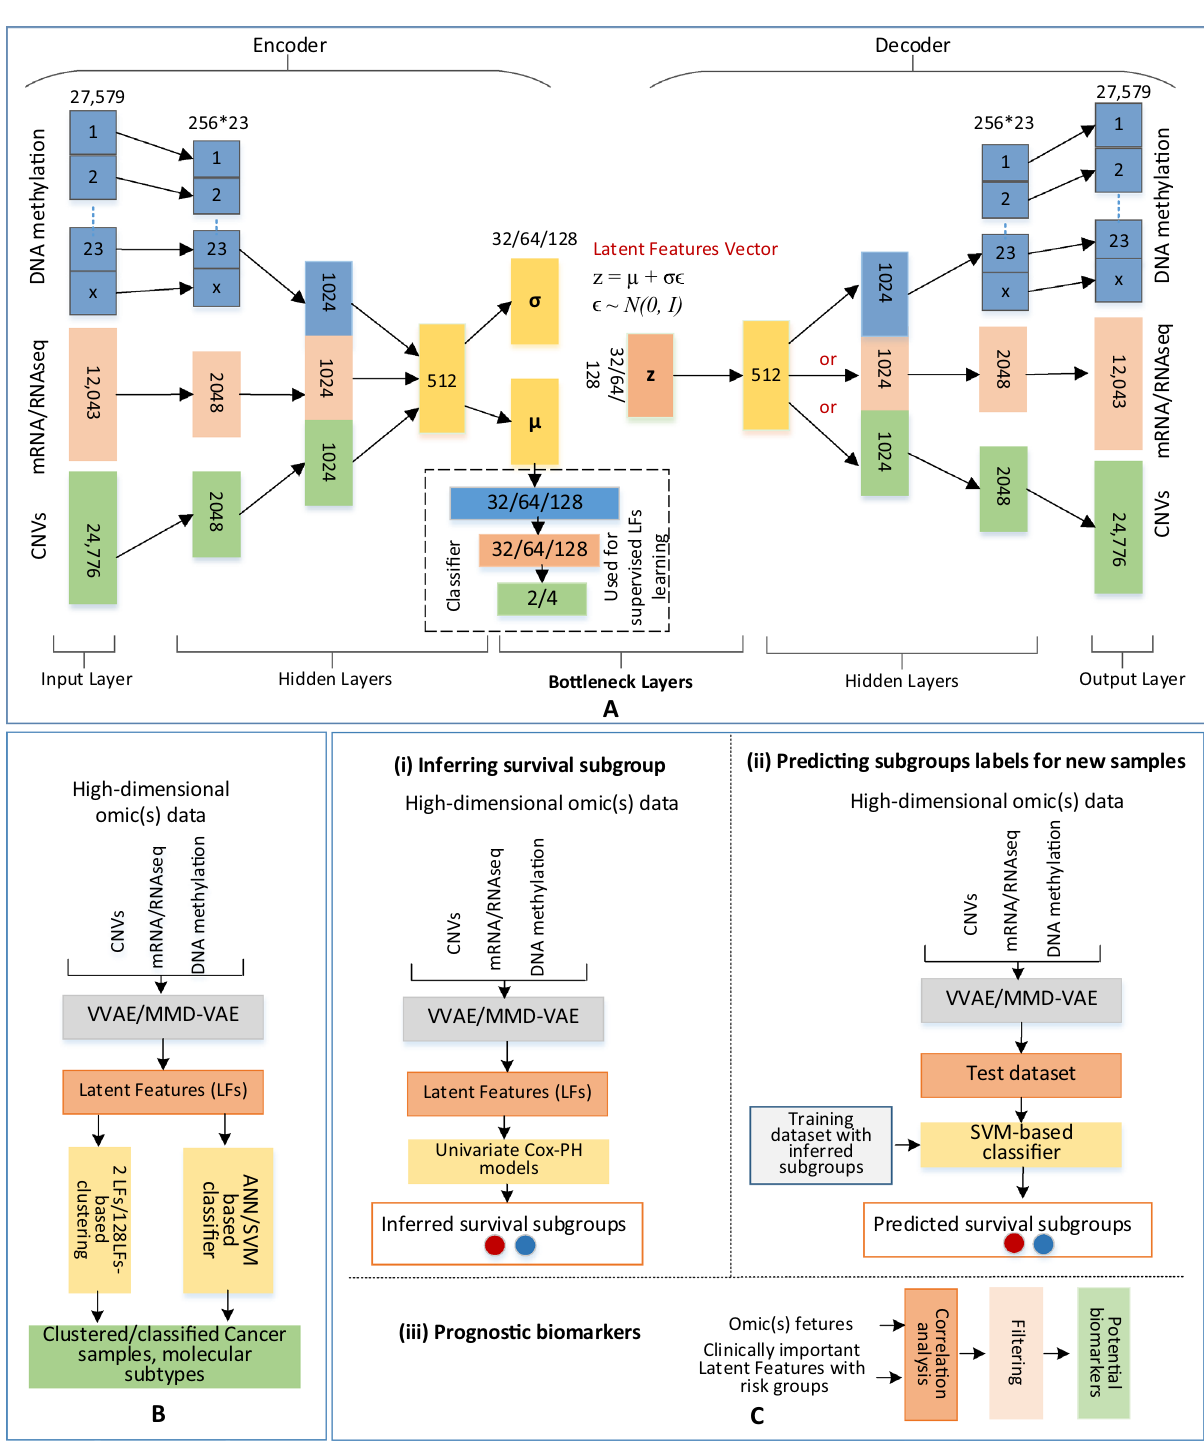
Figure 1. Methods: ( A ) VAE/MMD-VAE architecture consists of an encoder and a decoder made from 3 hidden layers and a bottleneck made from 2 layers and a 3-layered ANN-based classifier for supervised LFs learning, ( B ) Clustering using 2 LFs and ANN-based classification (e.g., cancer vs normal, and molecular subtypes) using 2 and 128 LFs, ( C ) Survival analysis using 128 LFs: (i) inferring survival subgroup, (ii) predicting subgroup and (iii) potential prognostic